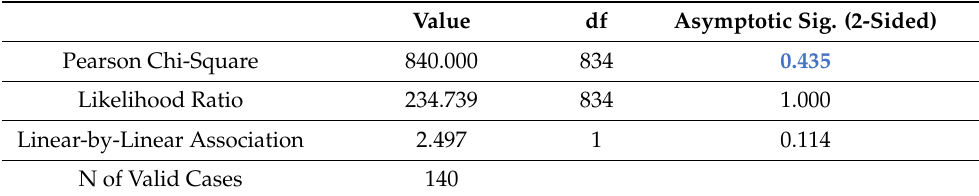
Table 20. The results for Chi-Square bivariate test.